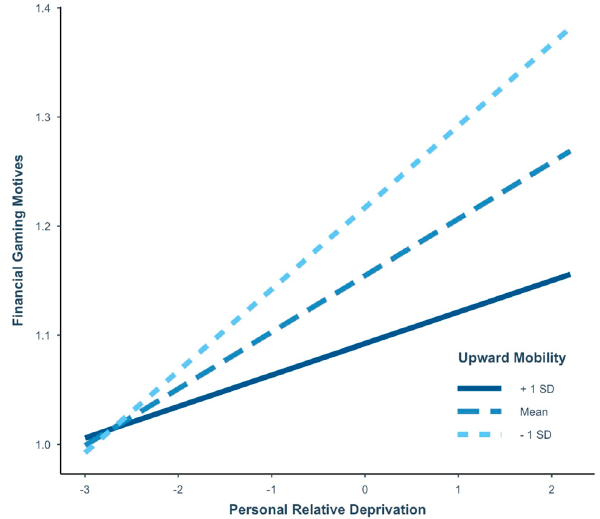
Figure 2. The conditional effect of perceived upward mobility on personal relative deprivation and financial video game motives for Study 1. All variables were coded to reflect more of the construct, with average scores computed for each participant. This figure represents the association between personal relative deprivation and financial gaming motives for U.S. college students at three levels of perceived upward mobility: (1) +1 SD above the mean, (2) the mean, and (3) -1 SD below the mean. Covariates included gender, income, loneliness, negative urgency, and positive urgency. n = 797.